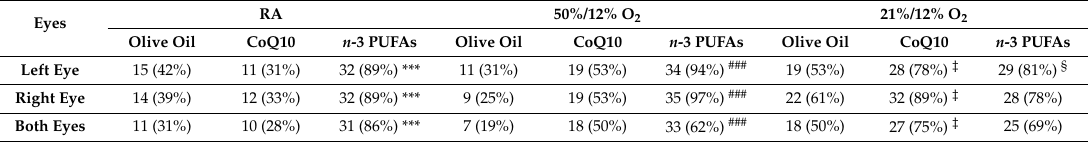
Table 1. Eye-Opening at Postnatal Day 14 (P14).